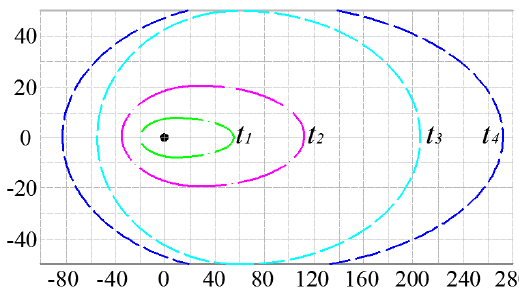
Figure 8. Sketch of grouting diffusion at a representative time (type 2).